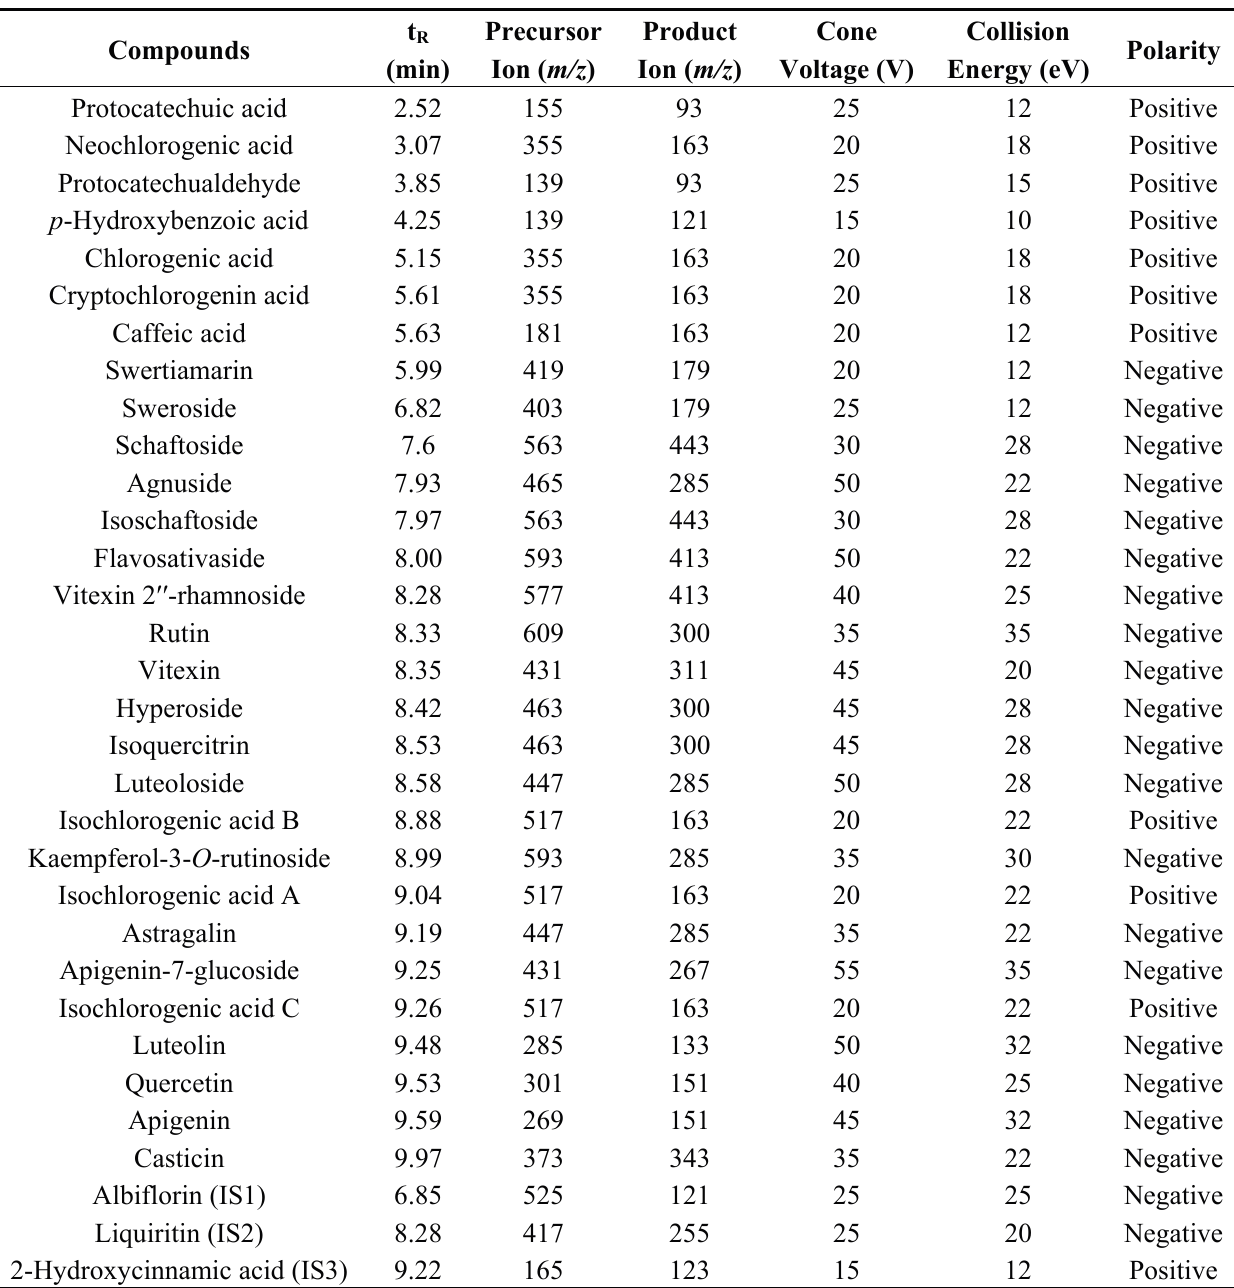
Table 1. Retention time, related MS data of 29 investigated compounds and three internal standards in the UPLC-QqQ MS